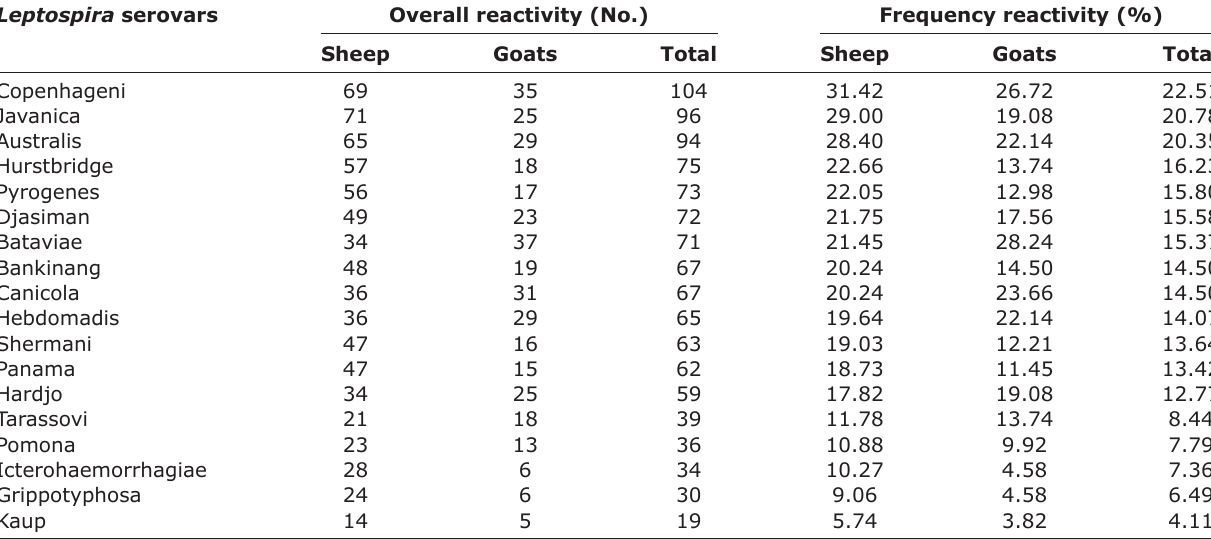
Table-4: Frequency distribution of predominantly reacted Leptospira serovars in small ruminants. Leptospira serovars Overall reactivity